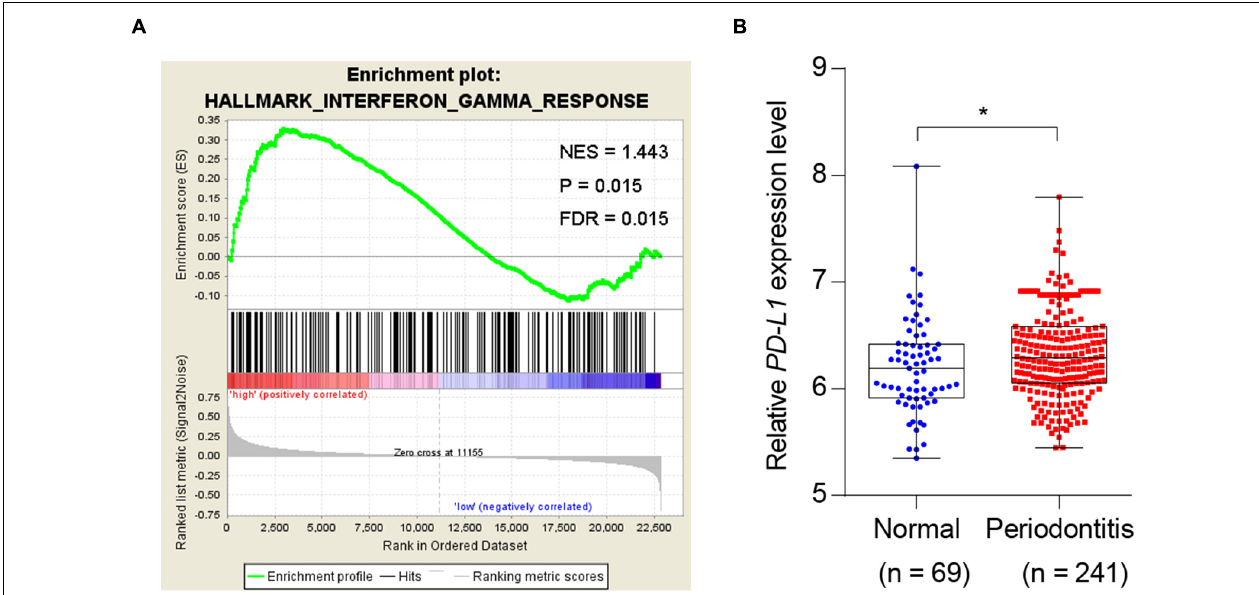
FIGURE 1 | Periodontitis correlated with inflammation and PD-L1 signatures. (A) PD-L1 gene signatures were analyzed by GSEA using the gene sets (GSE 16134) derived from periodontitis patients and normal subjects. FDR = 0.015. (B) Quantified results show the expression level of PD-L1 in the gene sets (GSE 16134). Periodontitis patients ( n = 241) compared with normal subjects ( n = 69). Error bars indicate SEM. ∗ P < 0.05 by Student’s t- test.